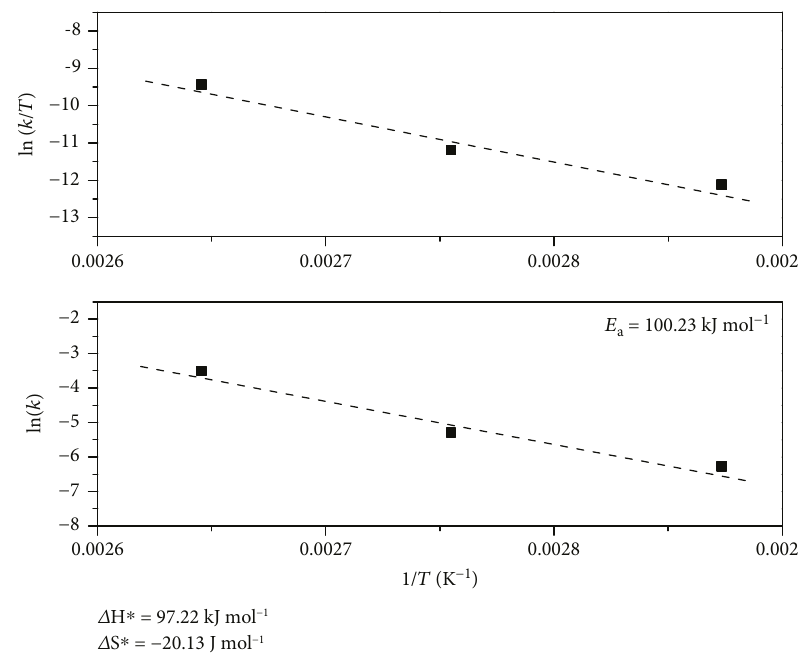
Figure 10: ln k and ln k/ T versus reciprocal of curing temperature of